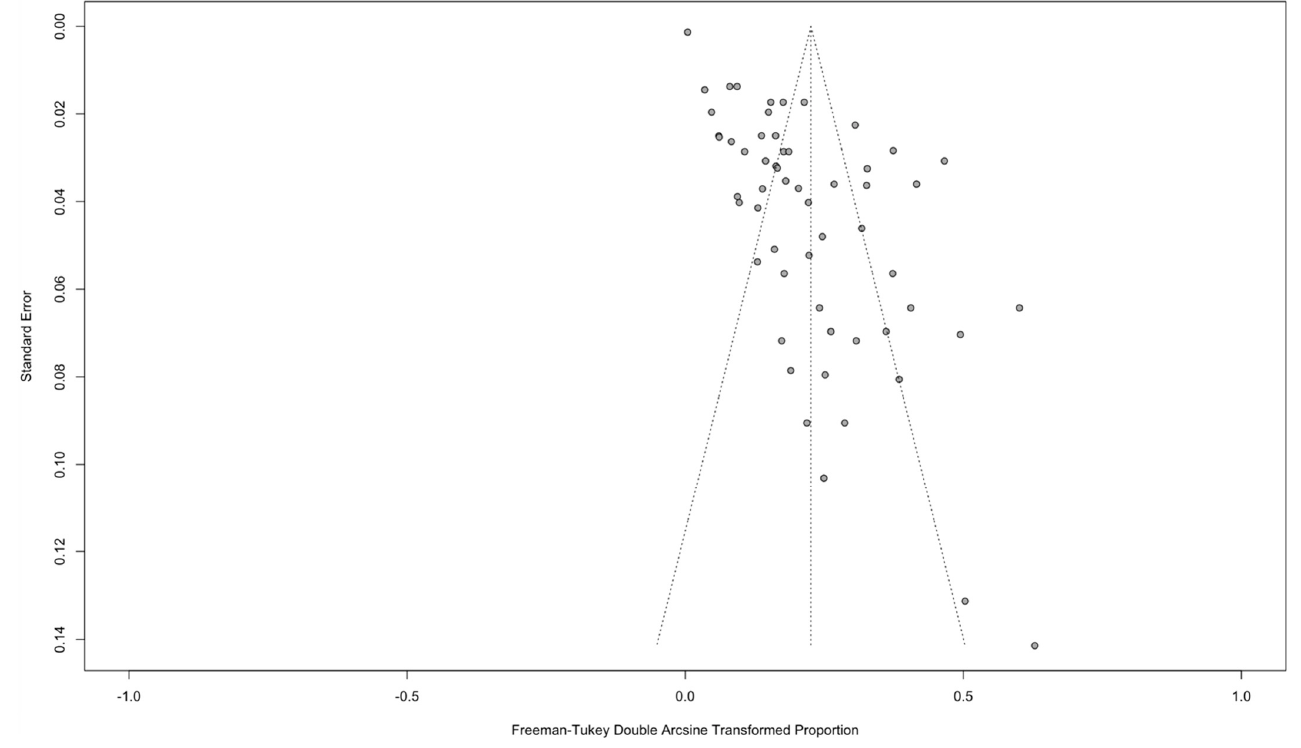
Figure 3. Funnel plot of included studies with phenotypic resistance.